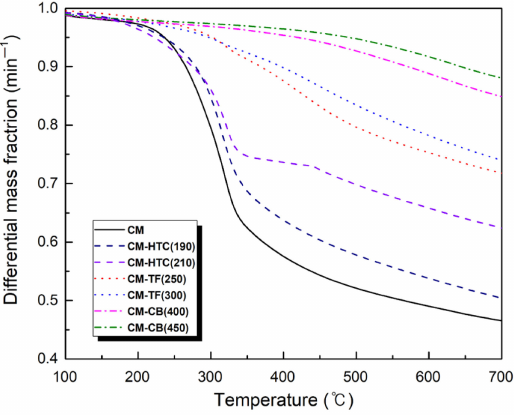
Figure 8. Experimental pyrolytic TG curves of the cattle manure, hydrochar, torrefied char, and biochar.